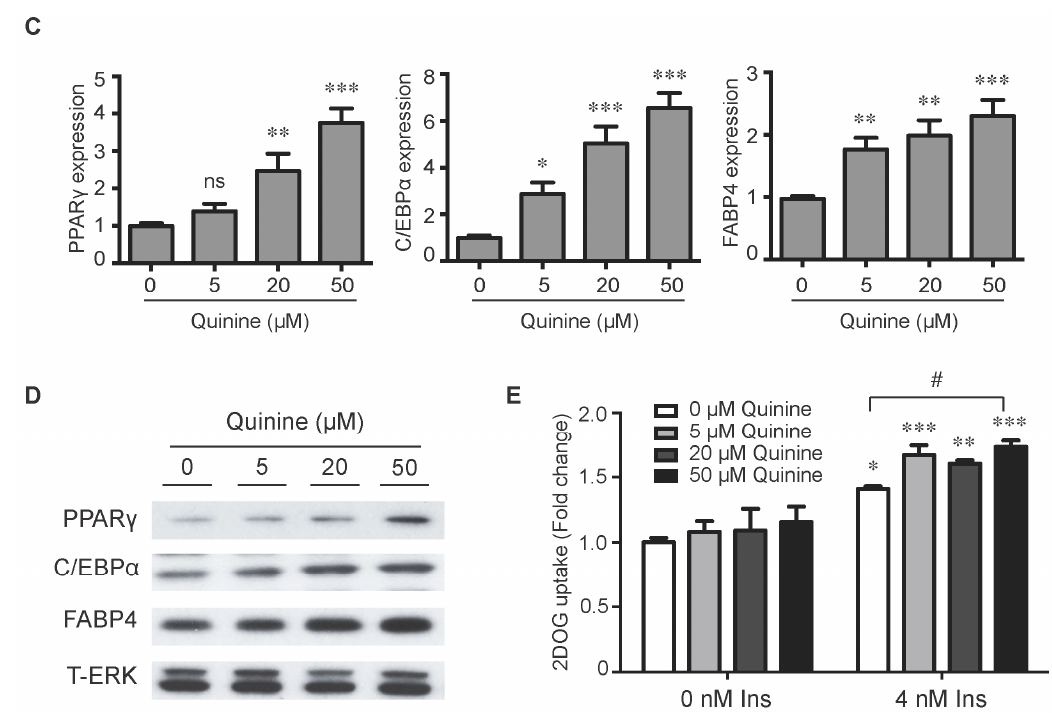
Figure 1. Quinine stimulated adipogenesis of mouse primary preadipocytes in a dose dependent manner. The effect of quinine on differentiation of mouse primary preadipocytes was assessed using Oil Red O stain, qRT-PCR, Western blot and glucose uptake assay, all these measurements were undertaken on Day 14 of differentiation with induction of MDI in the presence of quinine with indicated concentrations. ( A ) Oil Red O scan and micrographs (100×) showed lipid accumulation (pictures shown here represent three independent experiments); ( B ) Quantification of Oil Red O stain from three independent experiments. Data are expressed as fold change compared with 0 µM quinine (mean ± SEM; one way ANOVA, *** p < 0.001); ( C ) mRNA expression of adipogenic markers (PPAR γ , C/EBP α and FABP4) were measured with qRT-PCR. Results are expressed as fold change compared with 0 µM quinine (mean ± SEM; n = 6; one way ANOVA, * p < 0.05; ** p < 0.01; *** p < 0.001); ( D ) The corresponding protein levels of PPAR γ , C/EBP α and FABP4 were detected with Western blot. Total ERK (T-ERK) as loading control; and ( E ) Basal and insulin-stimulated 2-deoxyglucose uptake was measured as outlined in Materials and Methods. Ins represents Insulin. Results are expressed as fold change compared with cells treated with 0 µM quinine (mean ± SEM; n = 6; two way ANOVA; * p < 0.05, ** p < 0.01, *** p < 0.001 indicated 4 nM insulin compared with 0 nM insulin under each quinine concentration; # p < 0.05, indicated fold change compared with cells treated with 0 µM quinine under each insulin concentration).